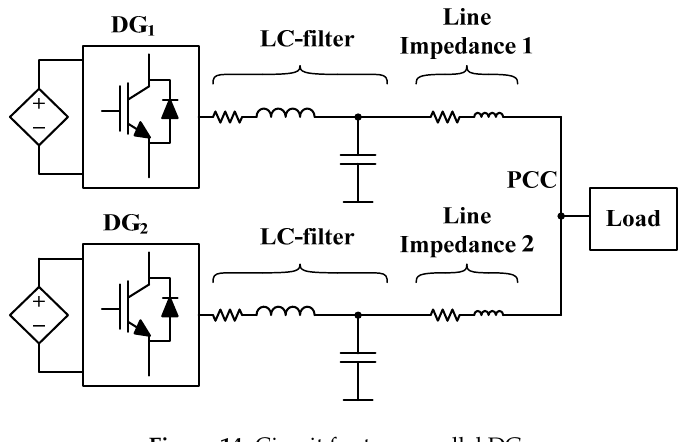
Figure 14. Circuit for two parallel DGs. Table 2. Circuit and control parameters.